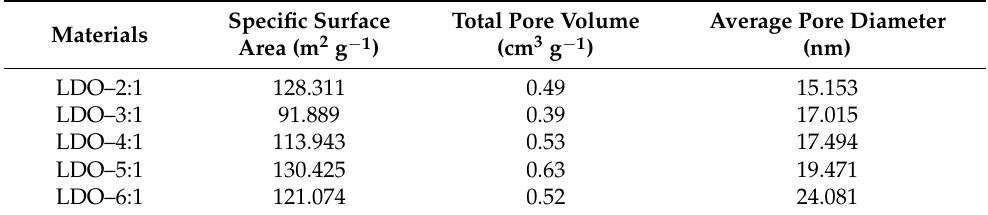
Figure 2. The textural properties of the adsorbents with different ion molar ratios. Table 2. Specific surface area, total pore volume, and average pore diameter of the LDO with different ion molar ratios.